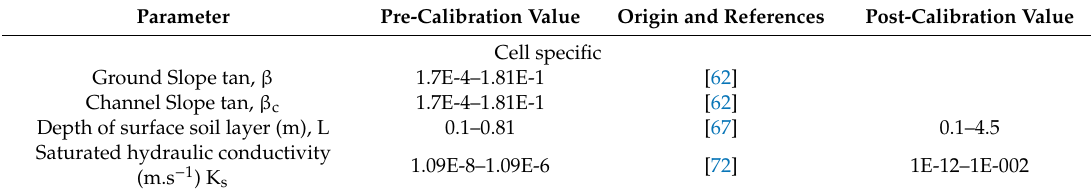
Table 1. Values of the TOPKAPI (TOPographic Kinematic APproximation and Integration) model parameters estimated a priori from data and literature, and values obtained from the calibration